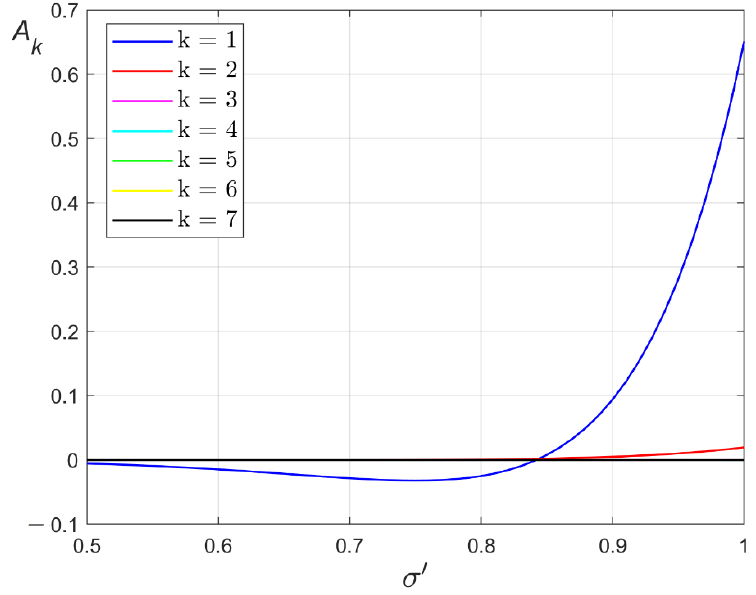
Figure 2. The dependence of amplitudes 𝐴 𝑘 (𝑧′, 𝜎′) on the parameter 𝜎 ′ at 𝑧′ = 1 . The amplitude 𝐴 1 modulus is significantly higher than those of the remaining am- plitudes 𝐴 𝑘 ( 𝑘 = 2,3, … ) at almost values 𝜎′ . The exception is the small area around the point 𝜎 0 ( 𝐴 1 (𝑧′, 𝜎 0 ) = 0 ). Such a point exists at all values 𝑧′ . The position of the point 𝜎 0 depends on 𝑧′ . The range of possible 𝜎′ values for different substances is calculated based on the Lennard-Jones potential parameters [37] and crystal lattice periods. This range is 0.8 ≤ 𝜎′ ≤ 1.2 for metals. The first two terms dominate the rest in the Fourier series for potential (7) at 𝜎′ > 0.9 . The potential is approximated by a simple formula in this case.